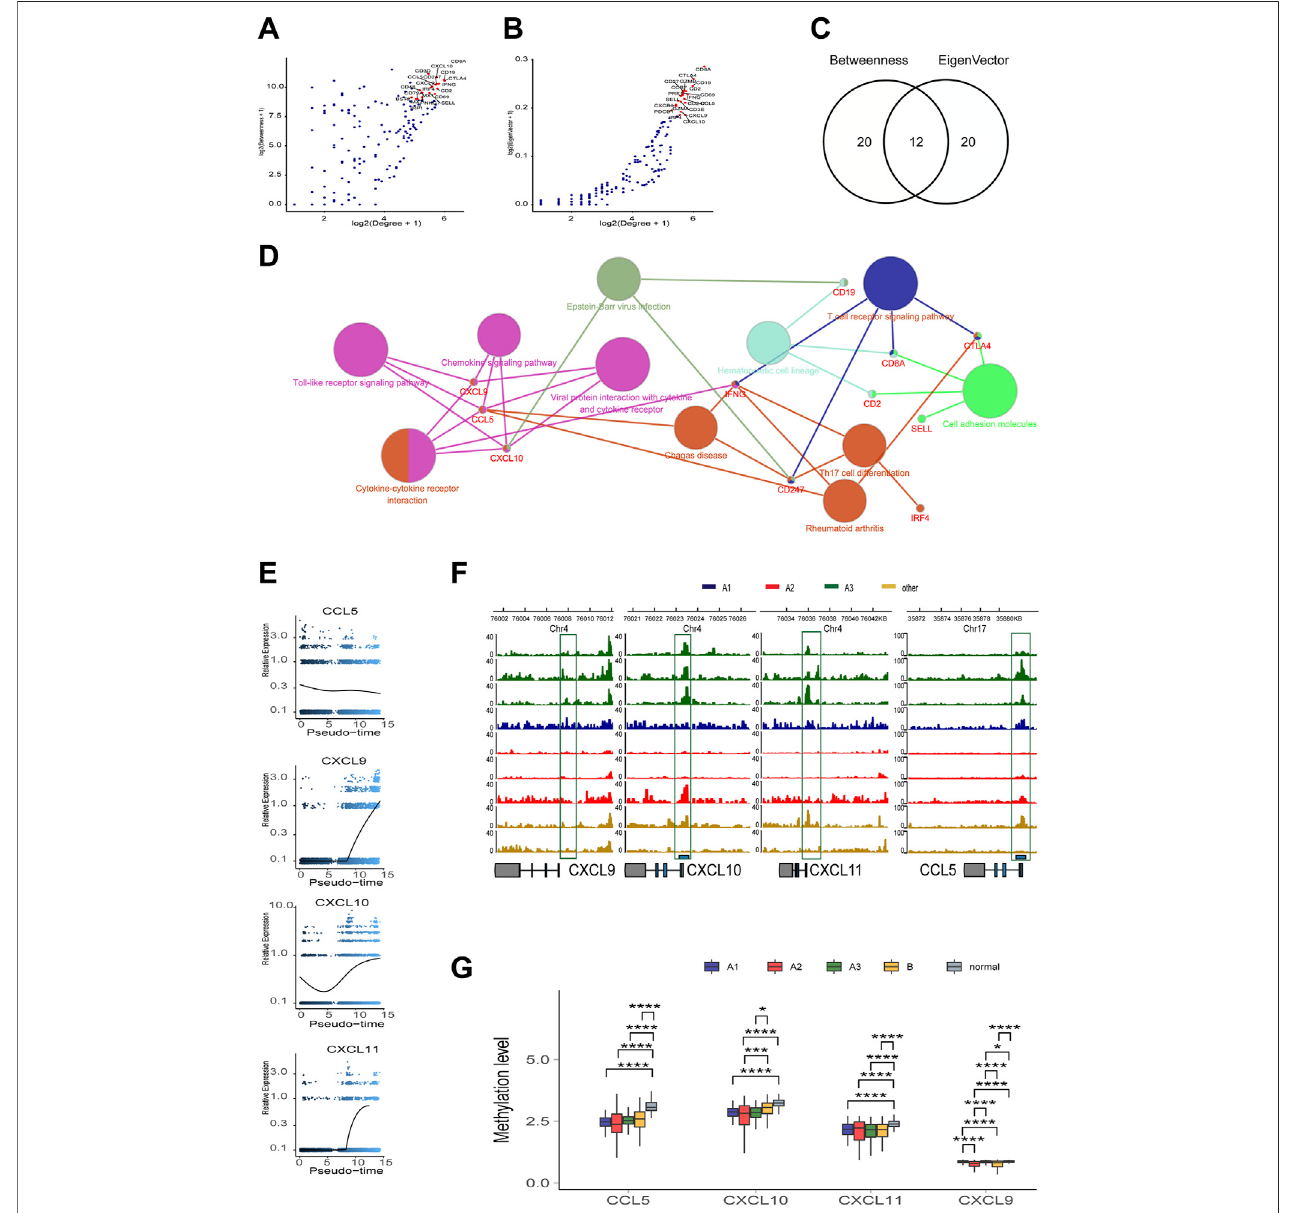
FIGURE 5 | The topological feature of the network composed of 181 genes. (A) Dotplot of -log2(Degree+1) and log2(Betweenness+1) in selected 181 nodes. (B) Dotplot of log2(Degree+1) and log2(Eigenvector+1) in selected 181 nodes. (C) Venn diagram of top 20 genes in A or (B) (D) KEGG pathway association network of 12 hub genes. (E) Trend of mRNA expression levels of the four chemokines (CXCL9,10,11, and CCL5) following the differentiation trajectory of TAMM. (F) Aggregation of ATAC-seq peaks of the four chemokines of nine patients in the transcription initiation region. (G) Methylation levels of the four chemokines in different HNSCC